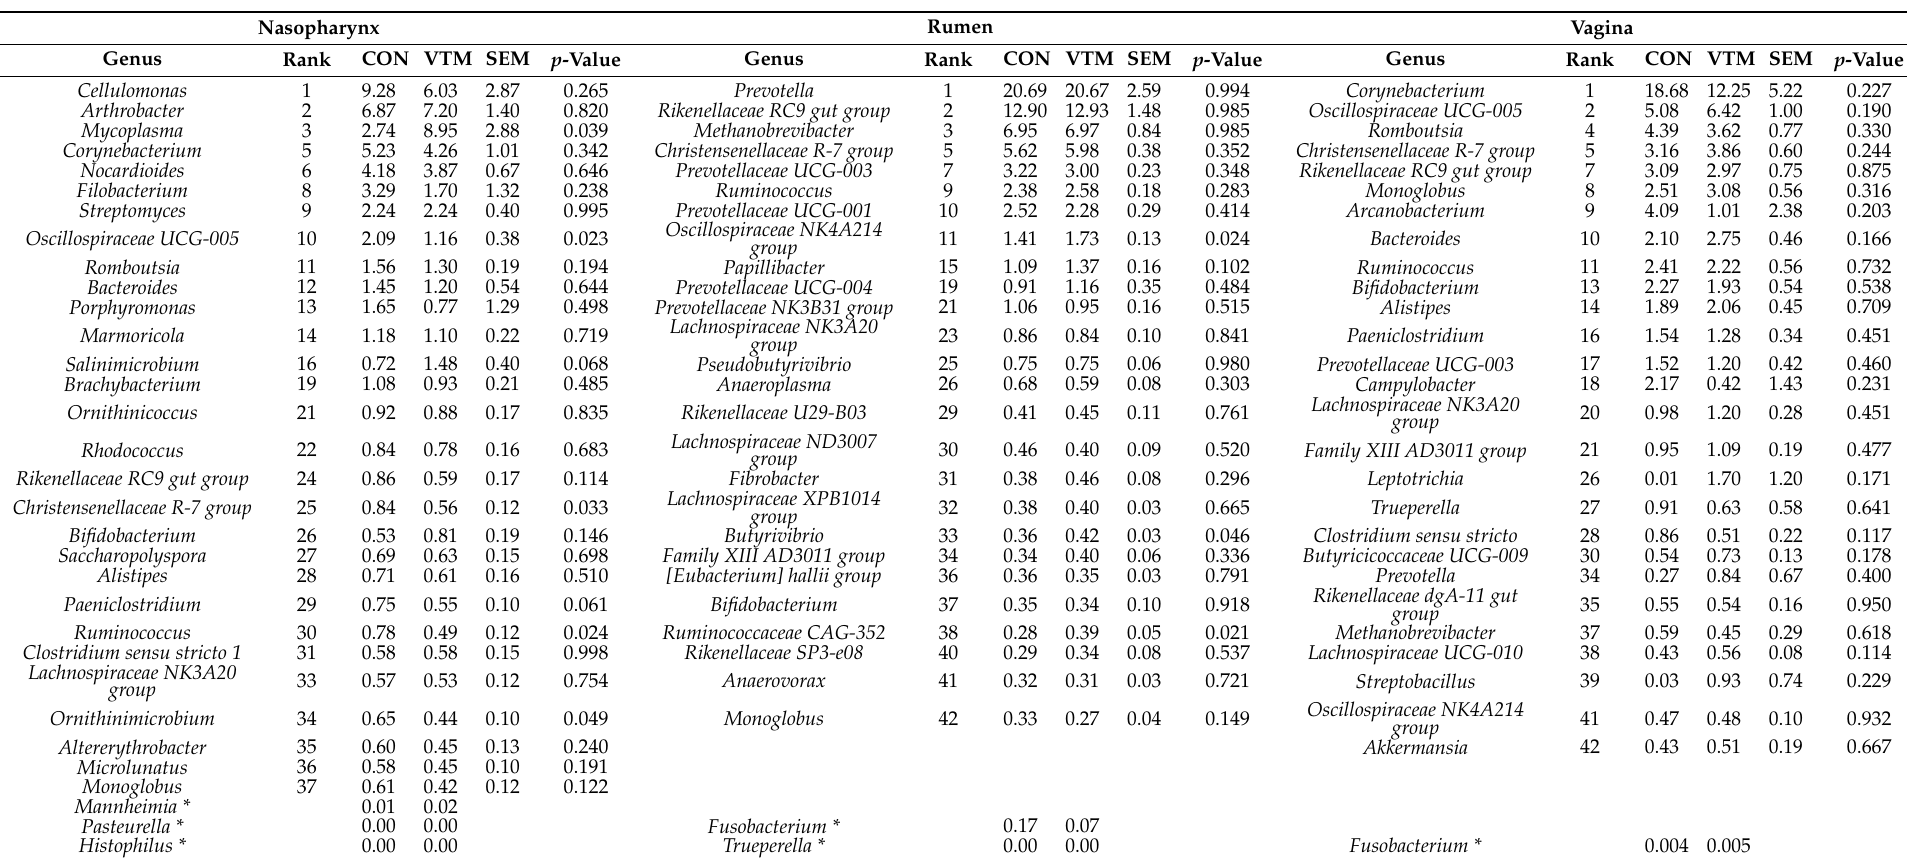
Table 3. Percent relative abundance of the 42 most relatively abundant genera in nasopharyngeal ( n = 29), ruminal ( n = 26) and vaginal ( n = 27) microbiota of received diets without (CON) and with vitamin and mineral supplementation (VTM) during the first 6 months of gestation 1